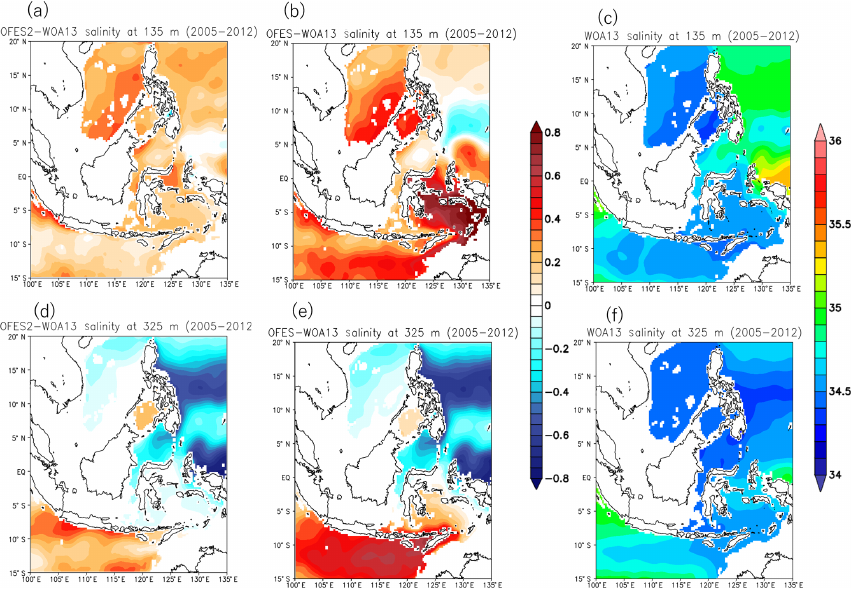
Figure 6. Salinity biases (a, b, d, e) against WOA13 (c, f) in OFES2 (a, d) and OFES (b, e) at 135m (a, b, c) and at 325m (d, e, f) . All fields are averaged over 2005–2012, and the units are practical salinity units (psu).